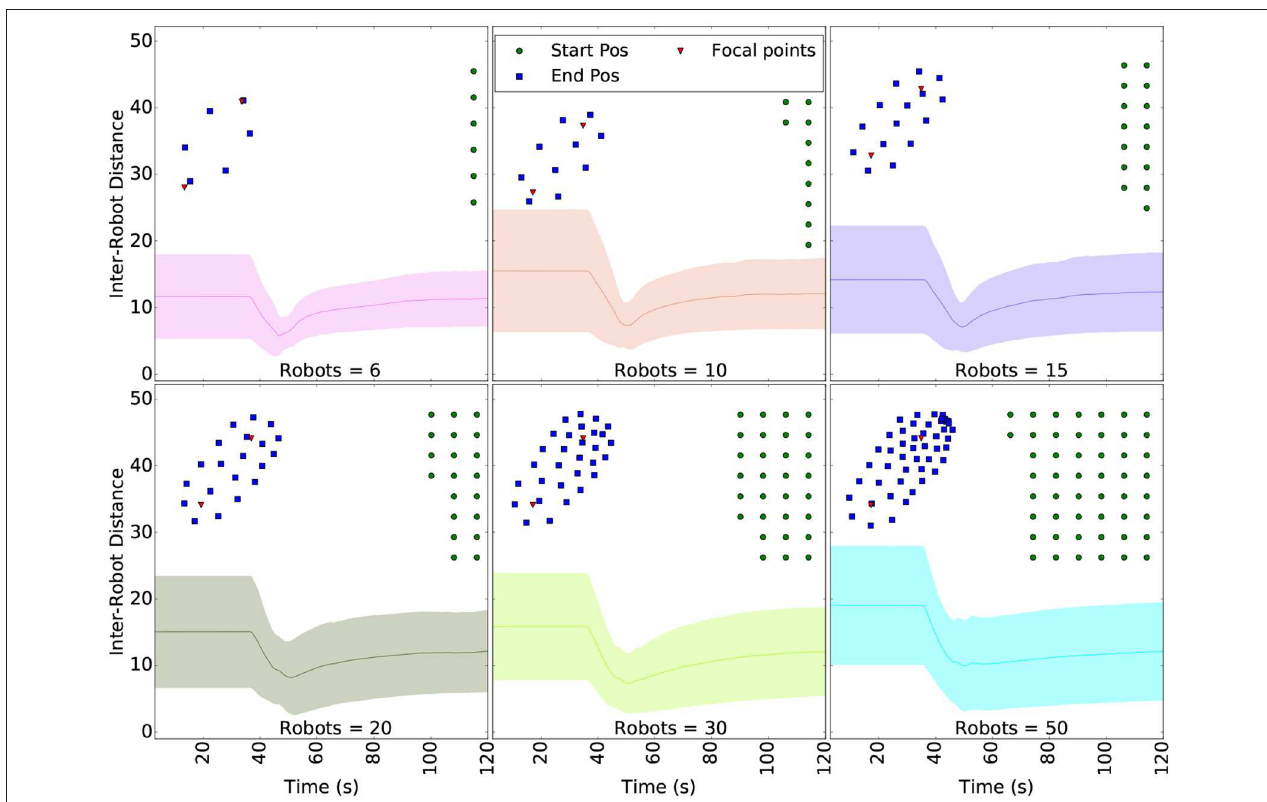
FIGURE 13 | Distance between the robots while navigating to the Voronoi centroids, as the number of robots in the swarm increases.